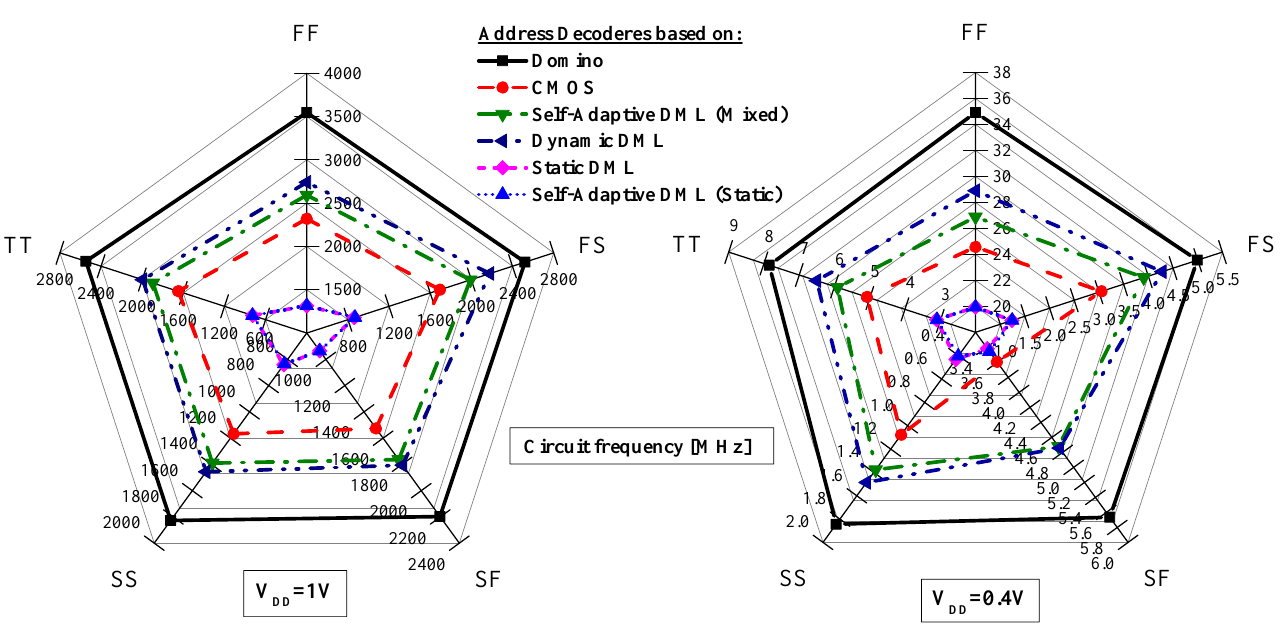
Figure 8. Address decoder process corner analysis at 1.0 V and 0.4 V.